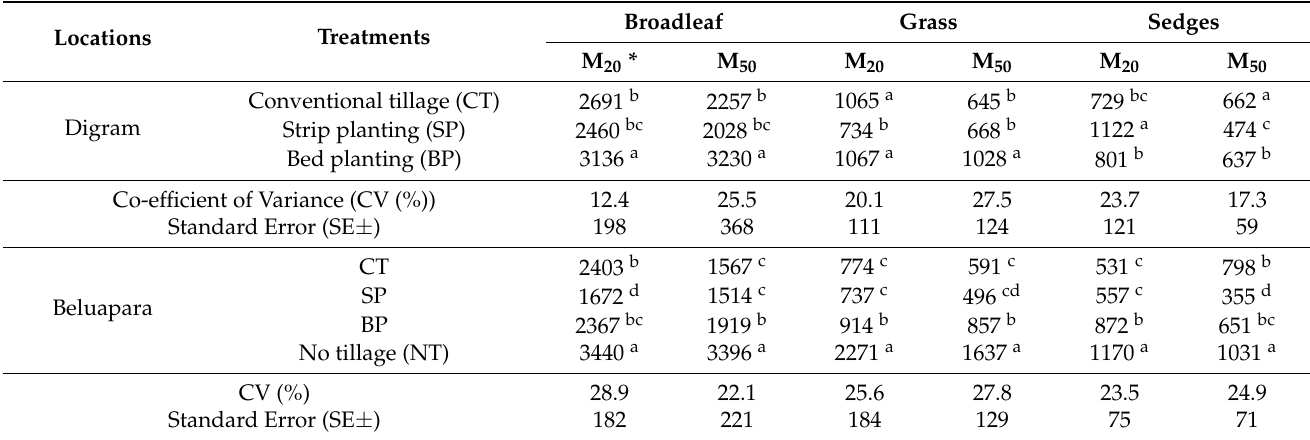
Table 5. Effect of different tillage and residue mulch on the abundance (no. m –2 ) of different weeds in Digram after 5 years and in Beluapara after 3